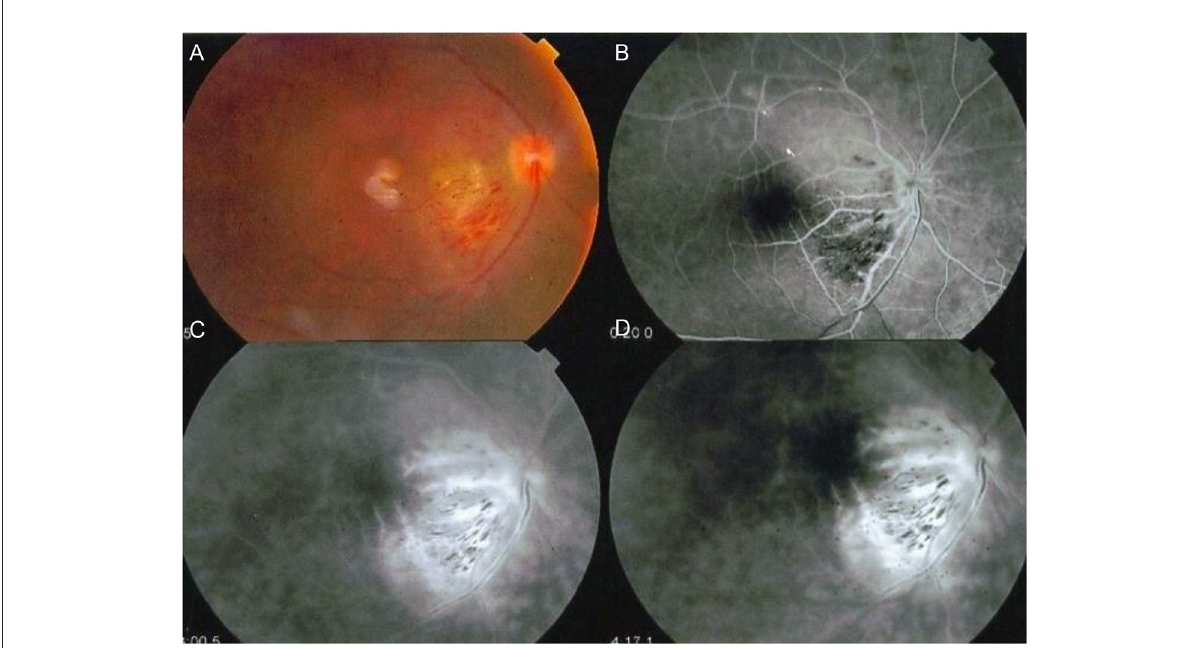
FIGURE3 FFA of a patient with Behçet s vasculitis. (A) Color photo showing macular branch retinal vein occlusion and disc edema. (B–D) FFA images showing the macular vein occlusion and widespread vasculitis with characteristic “fern-like configuration” (Images courtesy of Dr. Soliman MM, MD).